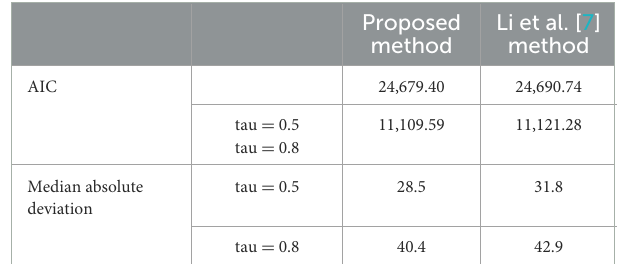
TABLE 5 AIC and median absolute deviation values of the two models for COVID-19